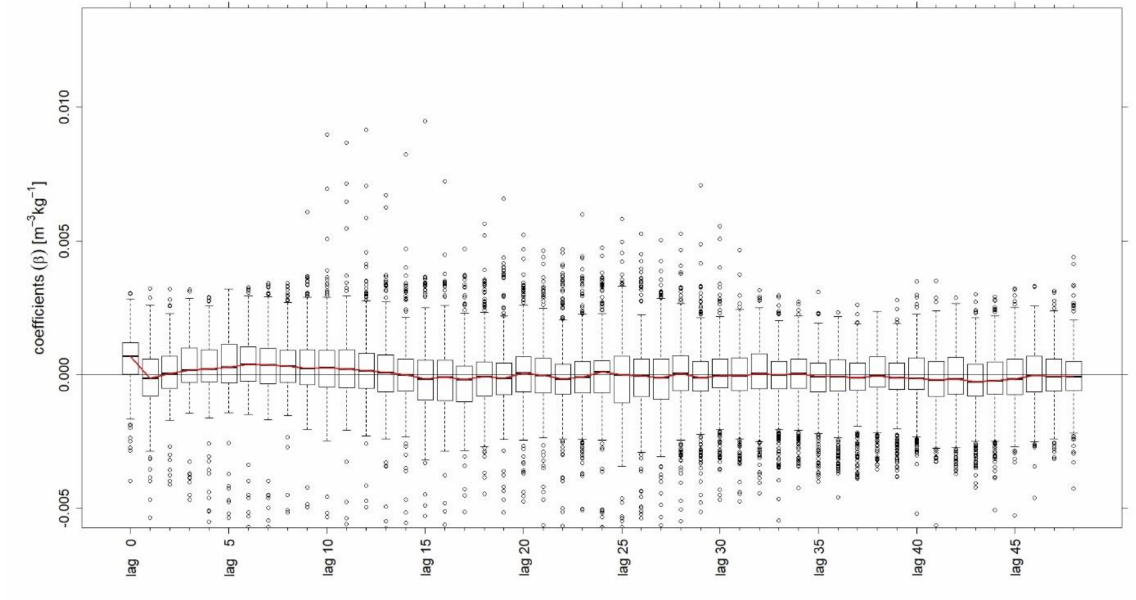
Figure 4. Boxplot with coefficients β of liquid substrate (liquid manure) feeding from simulation of digester two with 500 observations and 48